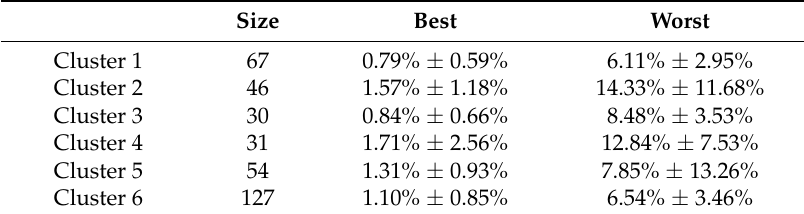
Table 3. Mean Absolute Percentage Error (MAPE) for the best and the worst forecasts in each cluster with standard deviation.